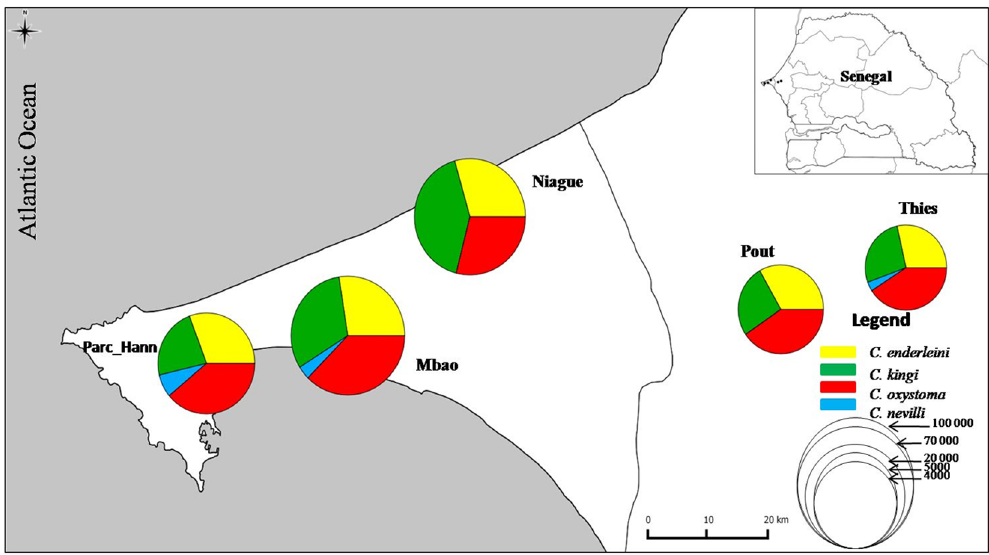
Figure 2. Location of the study sites in Senegal and abundance of species from the Schultzei group. doi:10.1371/journal.pone.0084316.g002 sterile water and 1 m l of DNA. Touch-up PCR amplification was used to reduce non-specific amplifications and optimize the quality